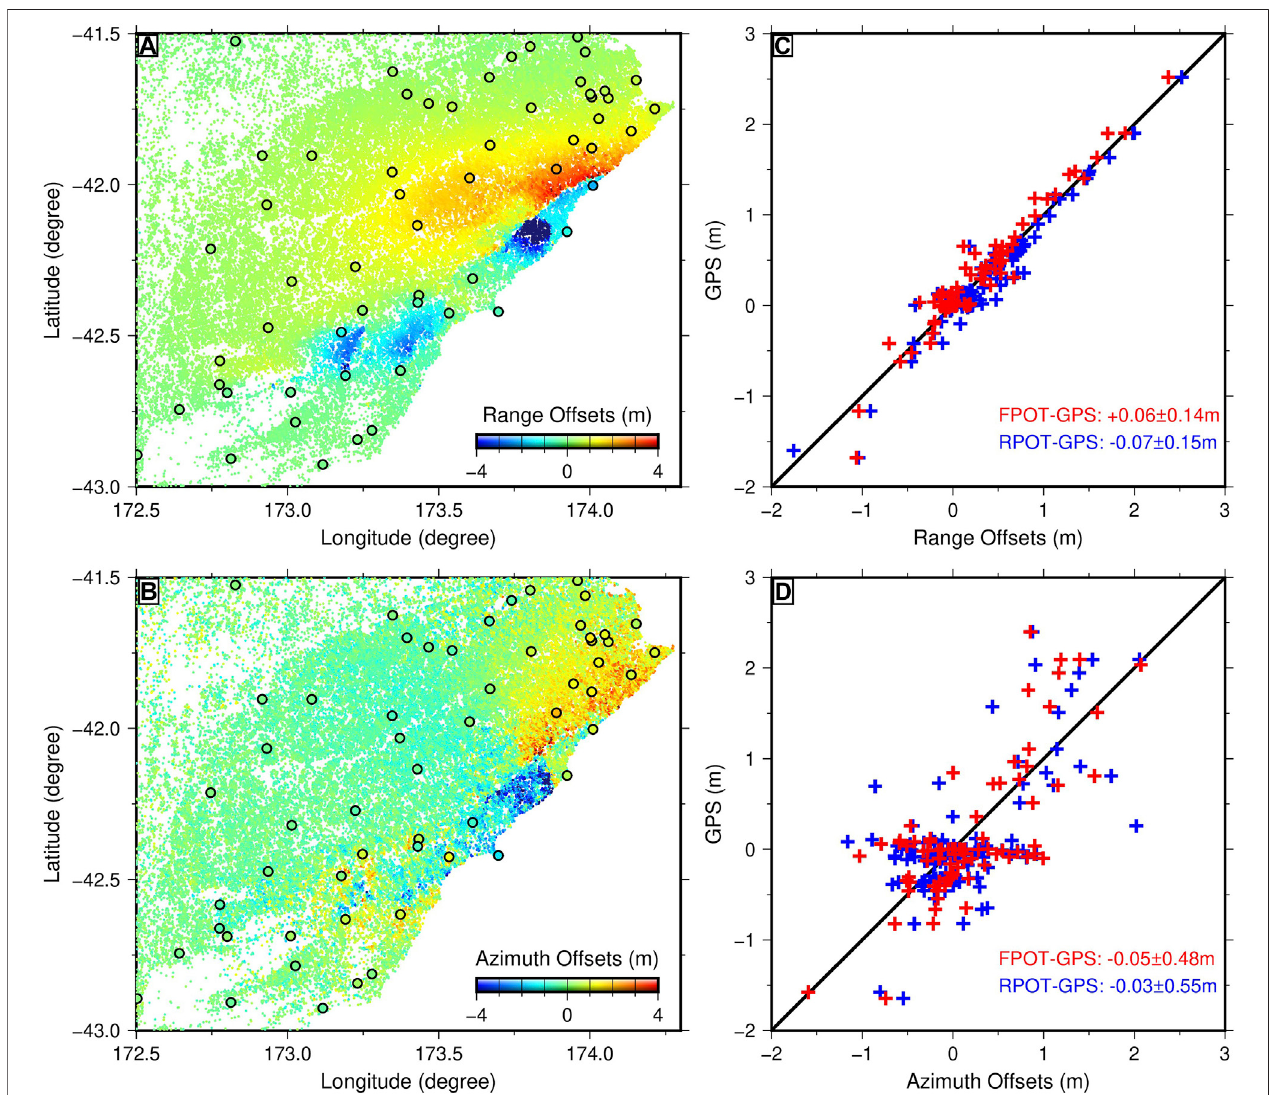
FIGURE6|(A,B) FPOT-derivedco-seismicdisplacementsinrangeandazimuthdirections,respectively.TheblackcirclesdenoteGPSsitescolor-codedwiththeir displacementsprojectedinrangeandazimuthdirections. (C,D) ScatterplotsshowcomparisonbetweenGPSdisplacementsandFPOT-derived(red)andRPOT-derived (blue) offsets in range and azimuth. The corresponding FPOT value is the average offset within a 500 × 500 m box surrounding each GPS site.